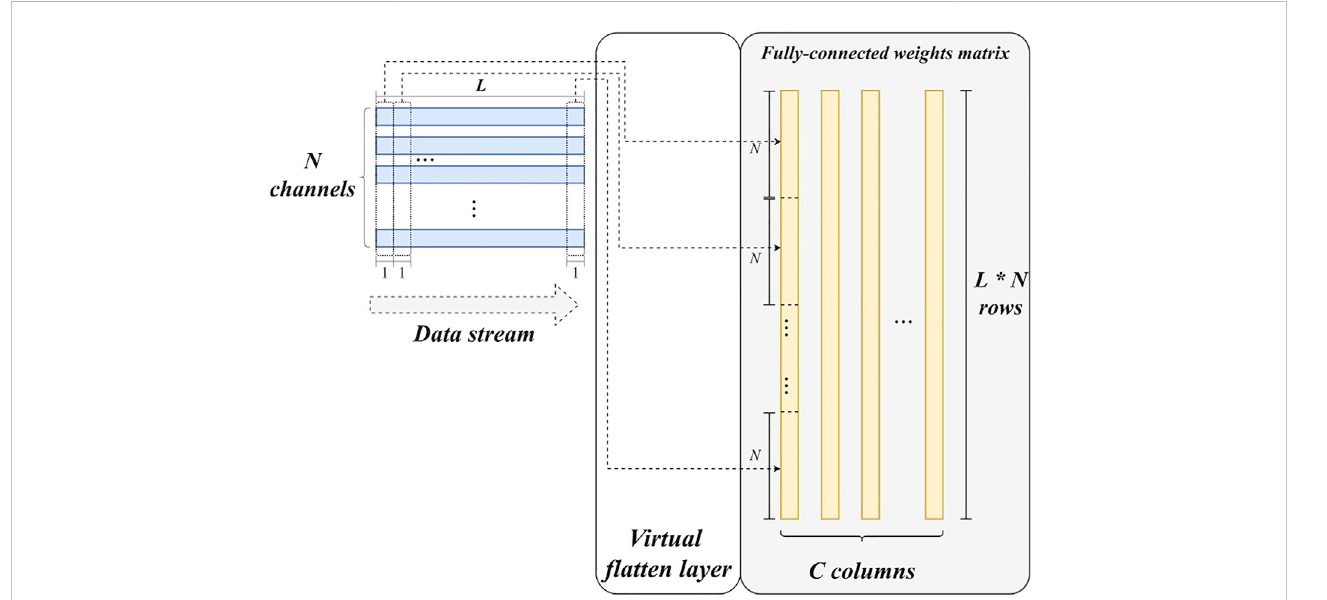
FIGURE 5 The hardware design of the virtual fl atten layer.